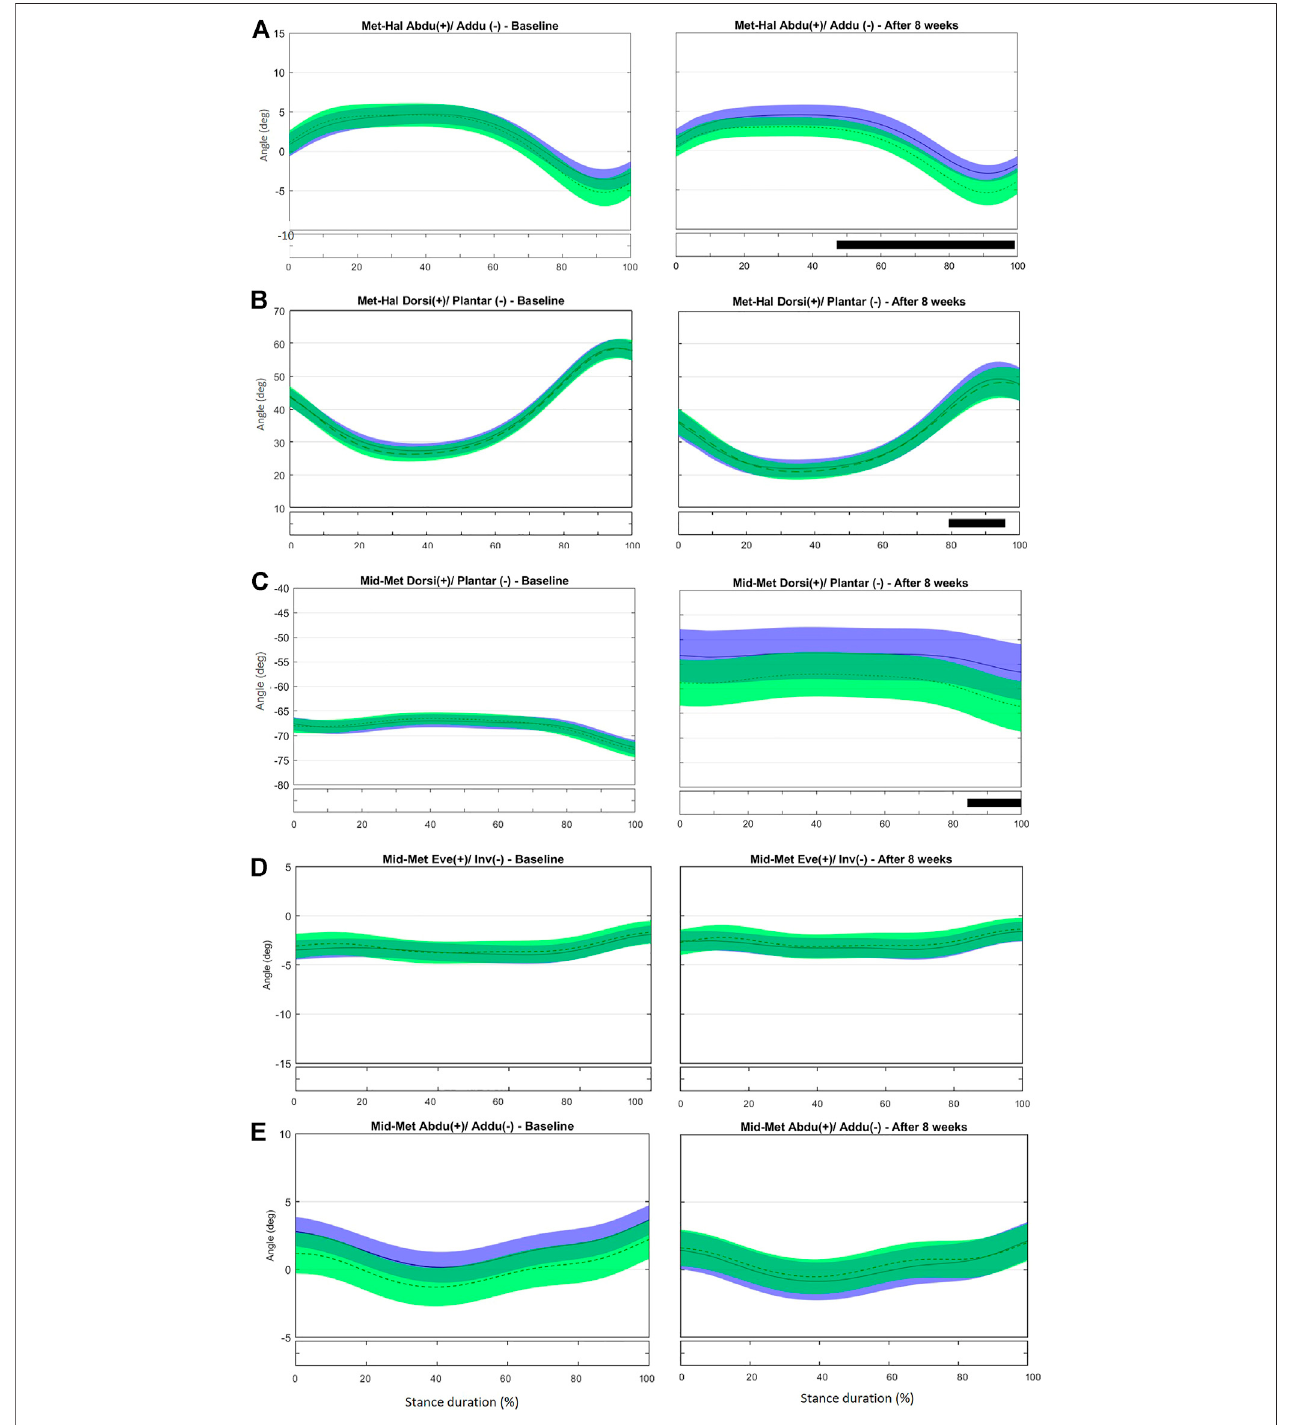
FIGURE3| Mean(±1SD)jointrotationanglesduringnormalizedstancephasedurationofrunninginthebaseline(left)andafter8 weeksofintervention(right).From top to bottom: transverse-plane rotations between hallux and metatarsus (A) ; sagittal-plane rotations between hallux and metatarsus (B) ; sagittal-plane rotations betweenmetatarsusandmidfoot (C) ,frontal-planerotationsbetweenmetatarsus andmidfoot (D) ,andtransverse-planerotationsbetweenmetatarsusand midfoot (E) . Green, CG group; Blue, IG group. The black bar below the graph represents the time during which the differences between the groups occurred ( p < 0.05), what was indicated by the SPM{t}